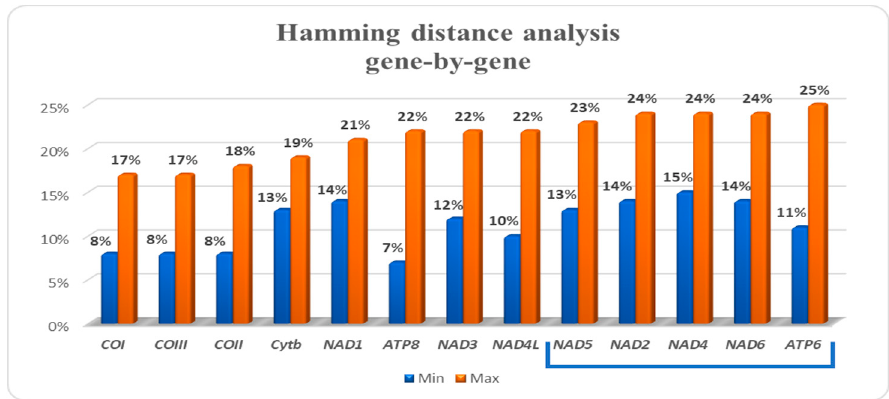
Figure 3. Gene-by-gene Hamming distance analysis carried out between P. erythrinus and other sparid species. The blue bracket shows the five less conserved mitochondrial genes in the Sparidae family.